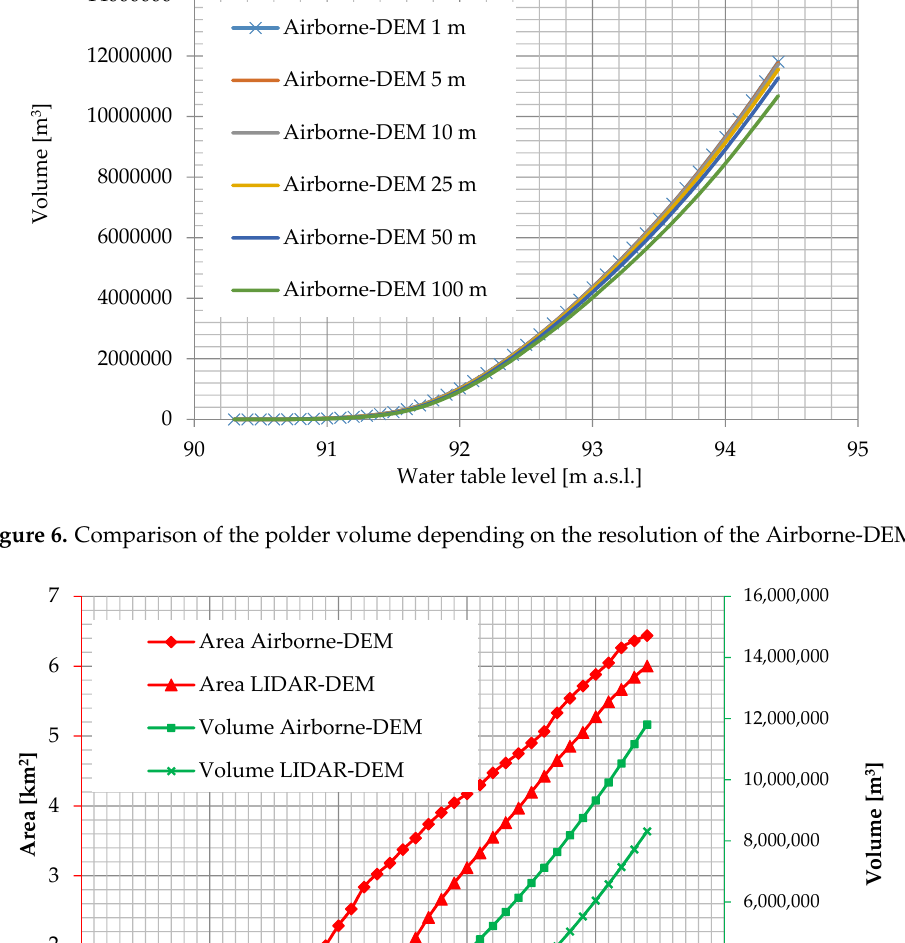
Water 2016 , 8 , 230